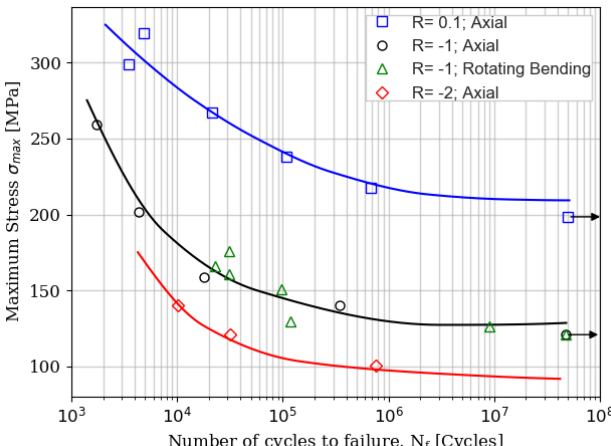
Figure 11: The S-N curves of extruded magnesium alloy AZ31 at different stress ratios 0.1,-1 and -2, and loaded both axially and in rotating bending conditions